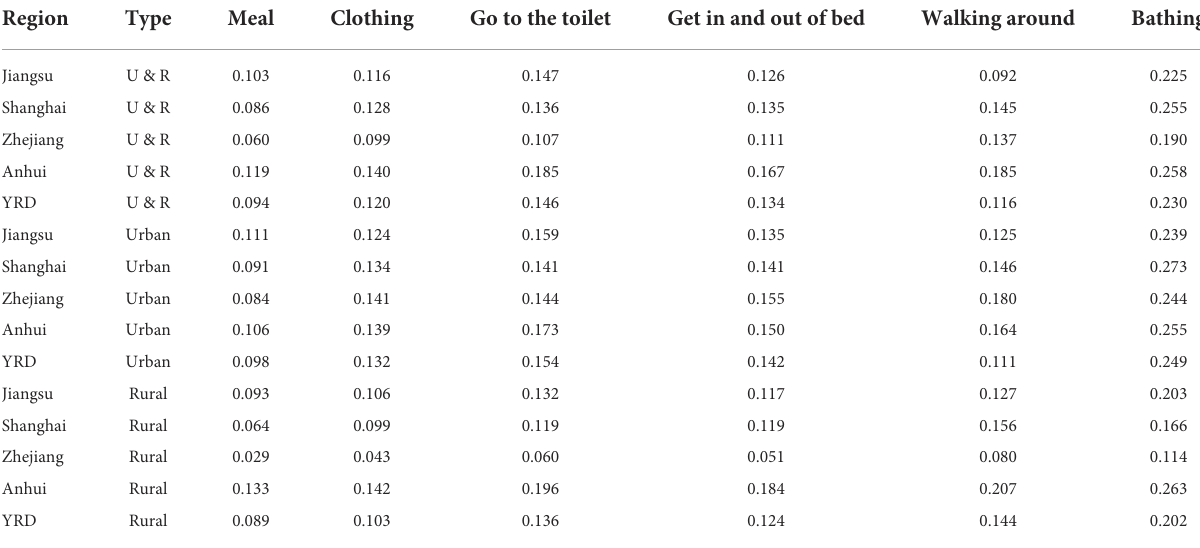
TABLE 4 Coefficients of variation for indicators of daily activities care. Region Type Meal Clothing Go to the toilet Get in and out of